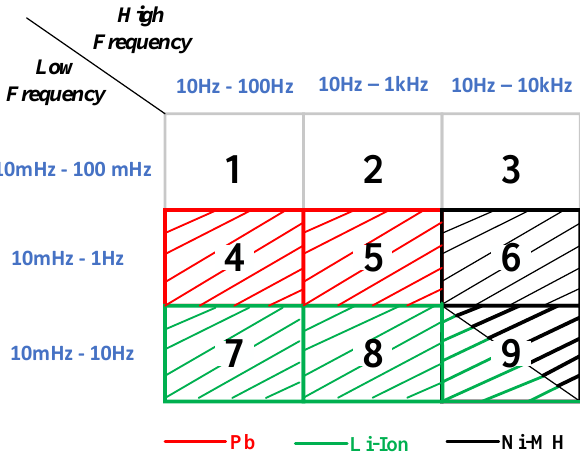
Figure 19. Matrix characteristics for the optimal frequency region depending on the type of battery.